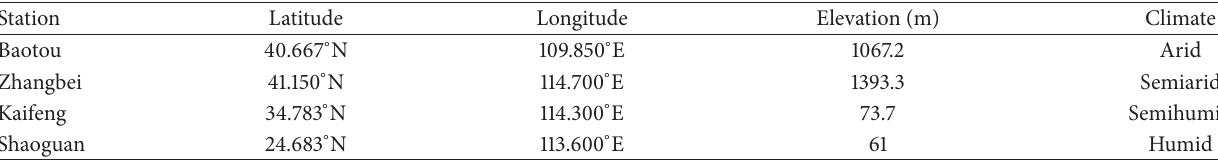
Table 1: Locations of weather stations under different climates.